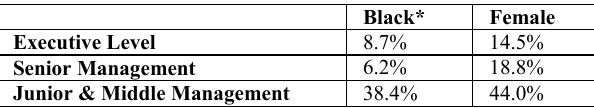
Table 1: Race and gender according to management